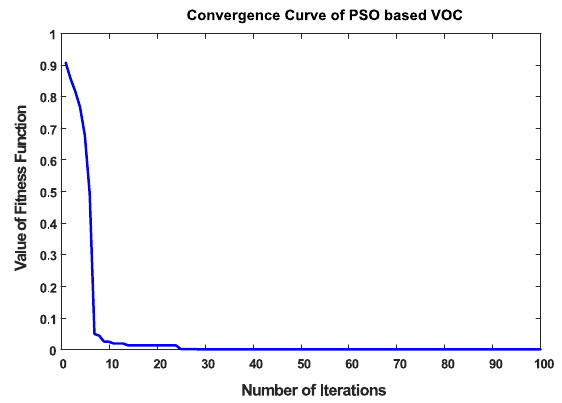
Fig. 9 Convergence curve of PSO-based